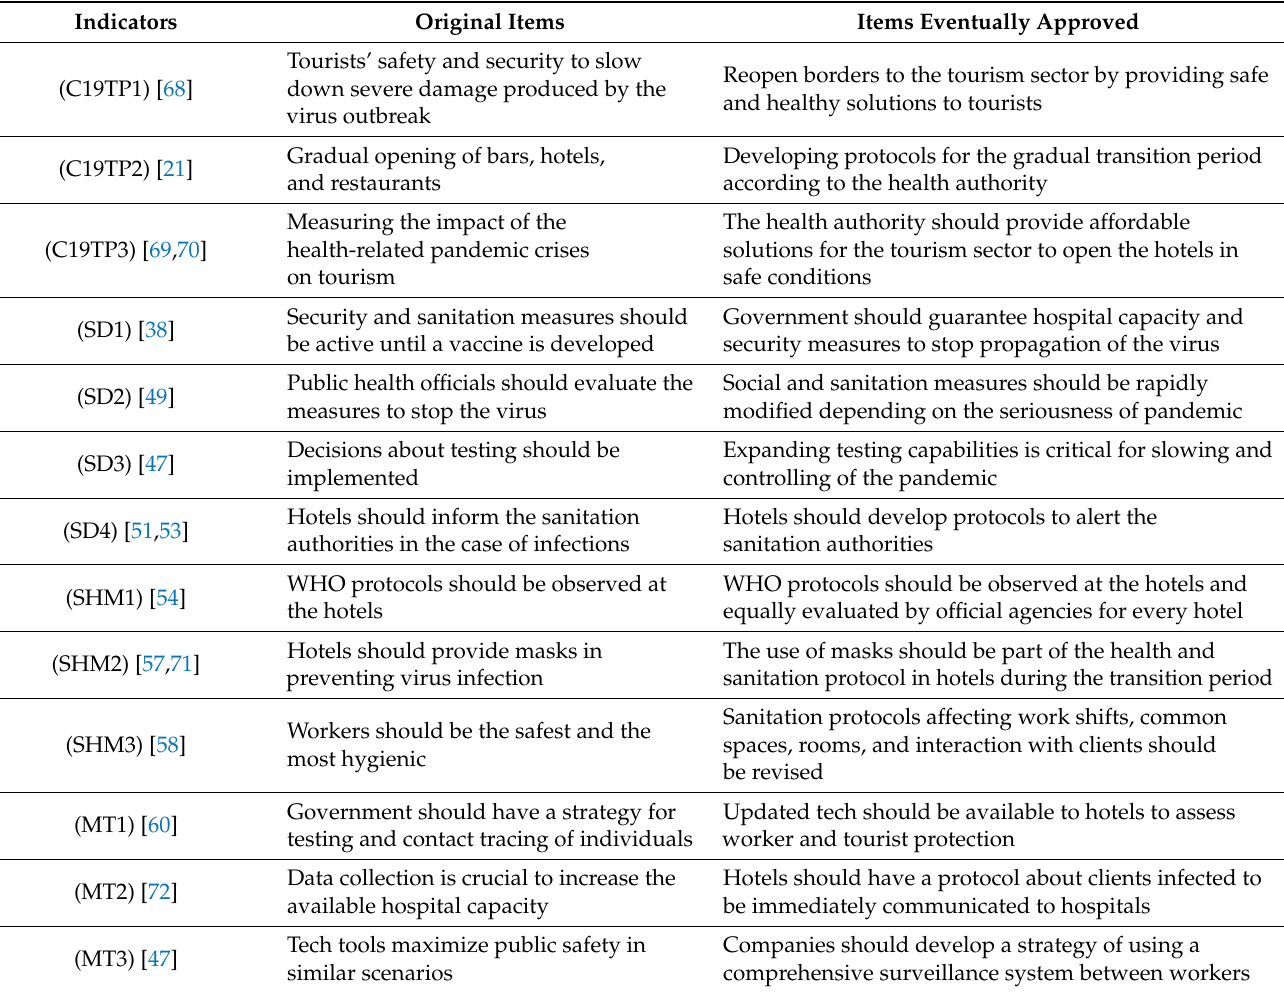
Table 5. Preliminary study and list of items corrected by the